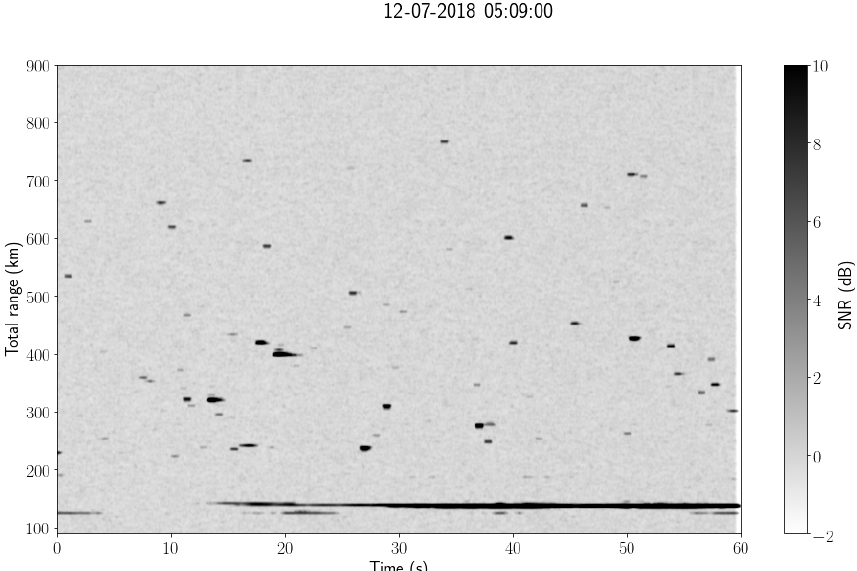
Figure 5. Similar to Fig. 3 but for MIMO-CW system, i.e., the signals of 25 synthetic receivers have been incoherently integrated. More than 45 specular meteor echoes can be observed, in addition to an airplane